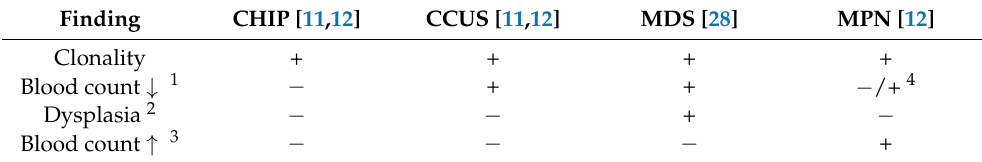
Table 2. Characteristics of CHIP and myeloid